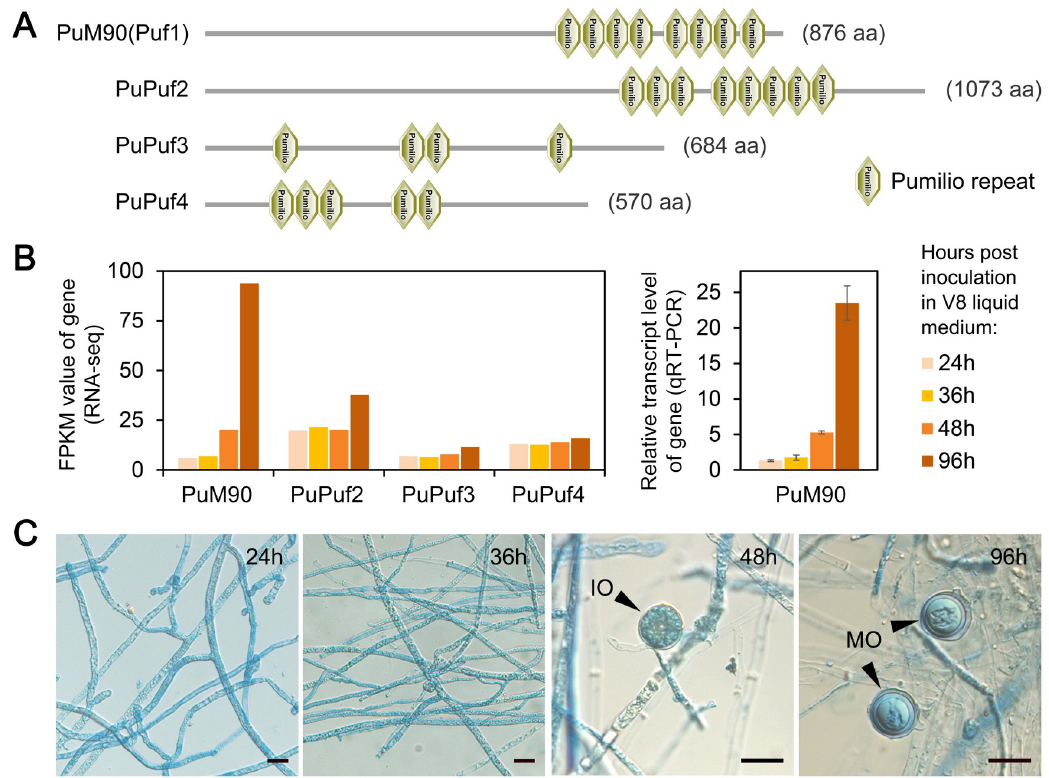
Fig 1. Characteristics of the Puf family in P . ultimum . (A) Predicted Pumilio repeats in Puf proteins. (B, C) Transcript levels of the Puf genes measured using RNA-seq (Left) and/or qRT-PCR (Right) (B), and sexual development of P . ultimum (C) when mycelia were inoculated in V8 liquid medium for 24, 36, 48, or 96 h. Cultures were stained with the lactophenol-trypan blue for 30 s before microscope observation. “IO” and “MO” indicate the oogonia with immature oospore and mature thick-walled oospore, respectively. Bar, 20 μ